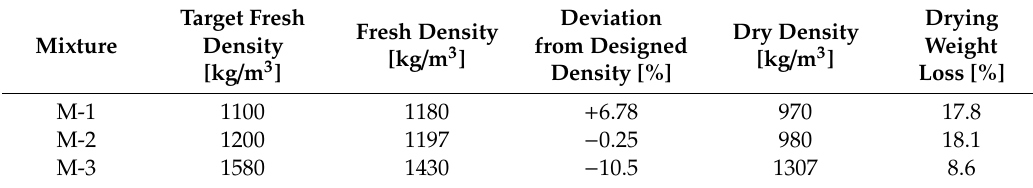
Table 7. Overview of density characteristics of the foam concrete compositions under